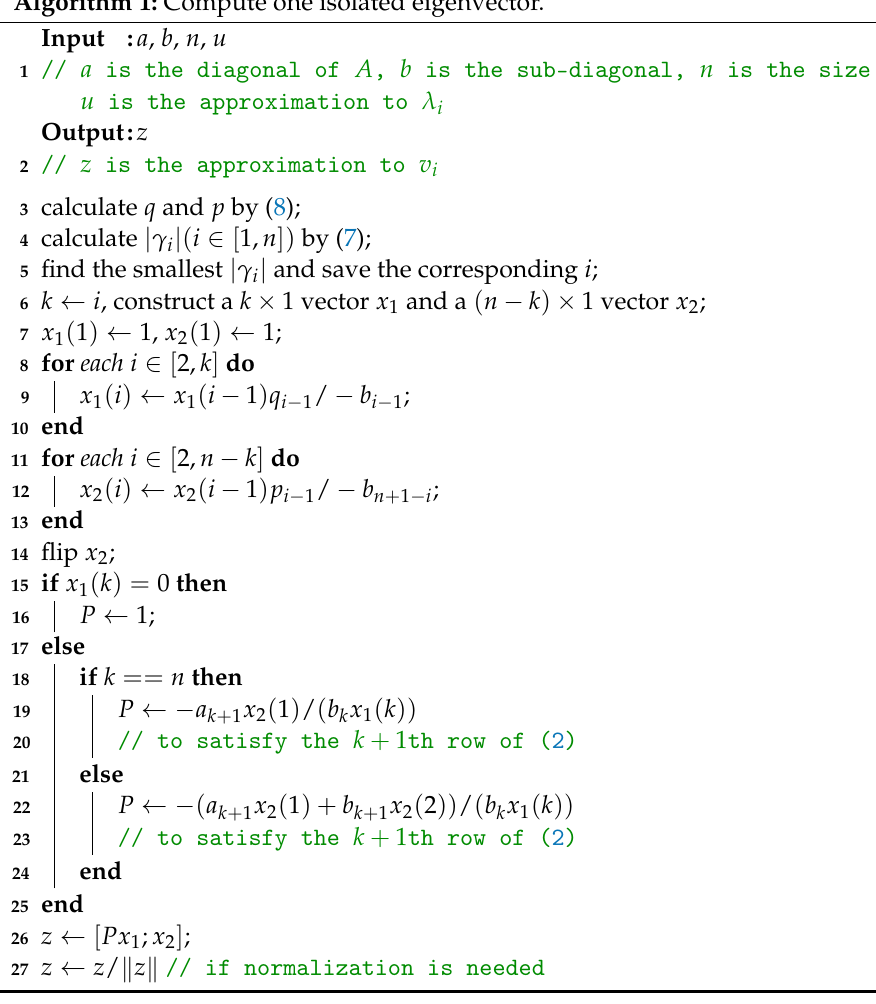
Algorithm 1: Compute one isolated